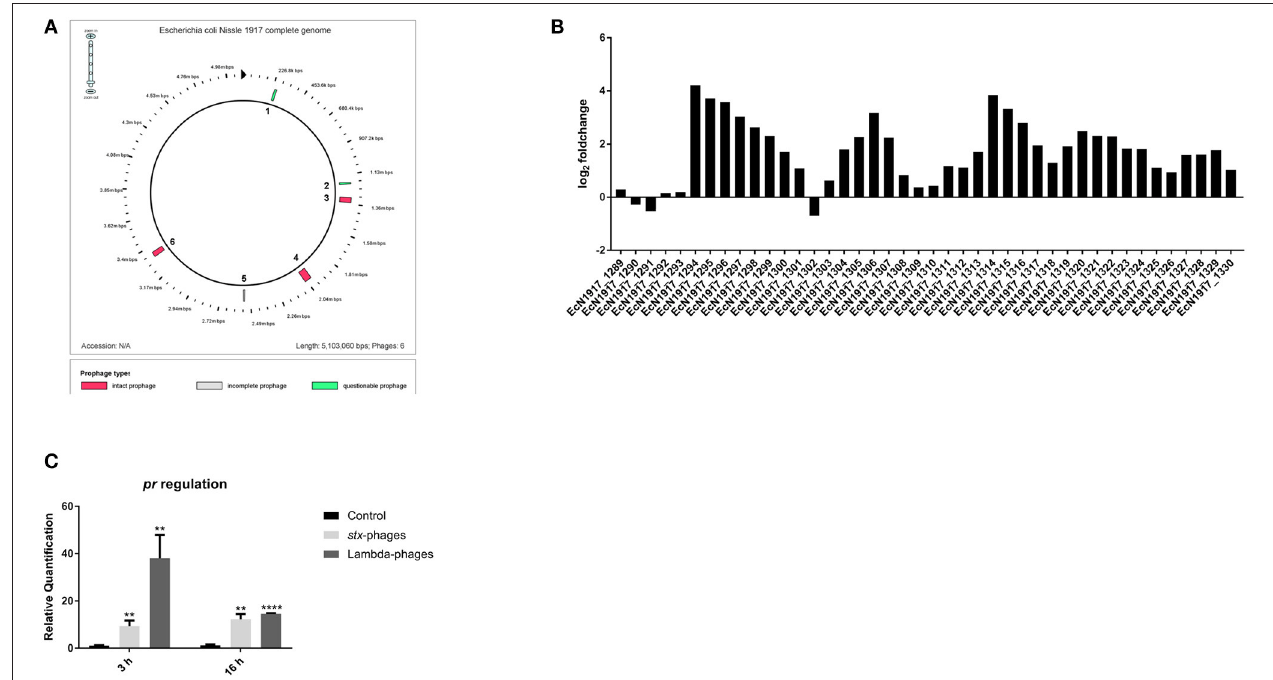
FIGURE 2 | Phage protection analysis of EcN. (A) Prophages predicted in the genome of EcN by PHAST. (B) Transcriptomic results of the upregulated genes of a lambdoid prophage in EcN after 16 h of incubation with stx -phages. (C) Verification of the transcriptomic results of the highly upregulated gene EcN1917_1294: phage repressor ( pr ) via qRT-PCR with the primer pair after 3 or 16 h of incubation with both lambdoid phages types. hcaT was used as reference gene. Control = EcN + LB-medium, ** p < 0.01 and **** p <